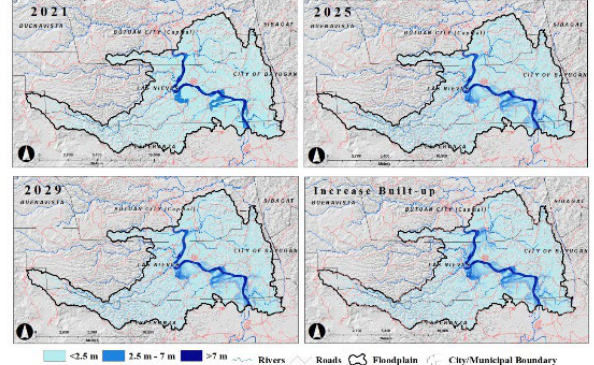
Figure 7. Flood depth maps with a 2-year rainfall